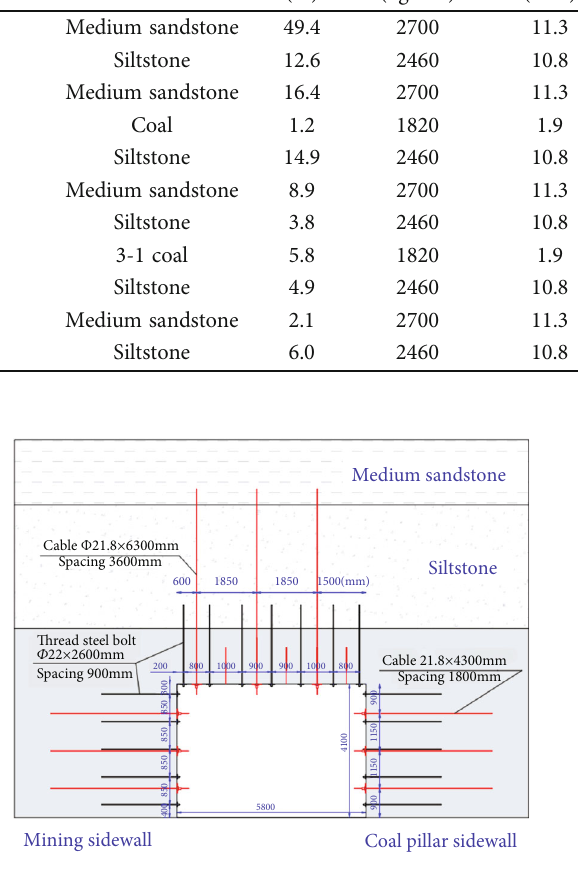
Figure 2: Supporting scheme of ATR